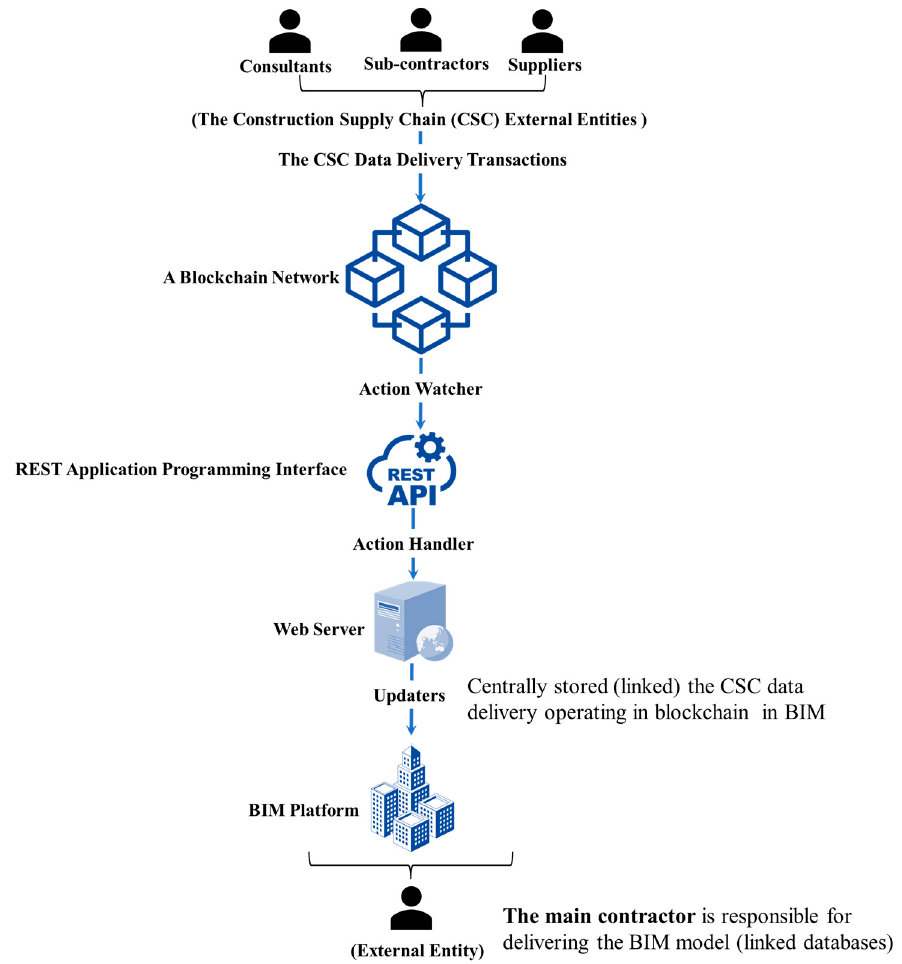
Figure 3. The proposed logical system architecture is independent of technology for the BIM single source of truth prototype using blockchain technology.